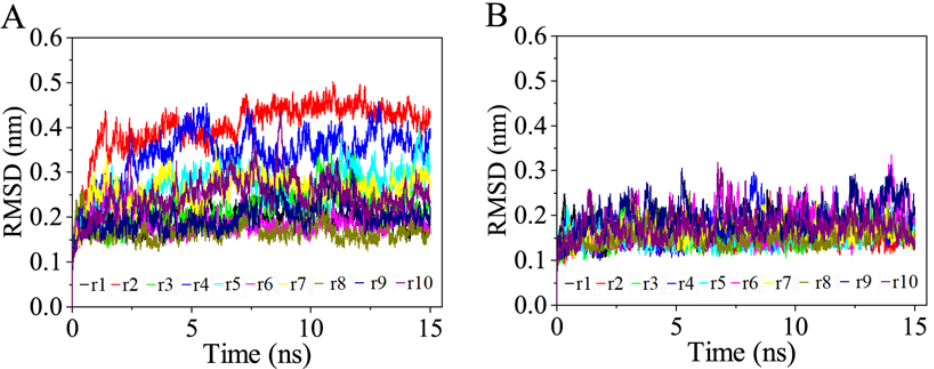
Figure 2. Time evolution of the C α root mean square deviation (RMSD) values of the two complexes relative to their respective starting structures calculated from the 10 independent MD simulation replicas (r1–10). ( A ) RBD CoV -ACE2 complex. ( B ) RBD CoV2 -ACE2 complex.